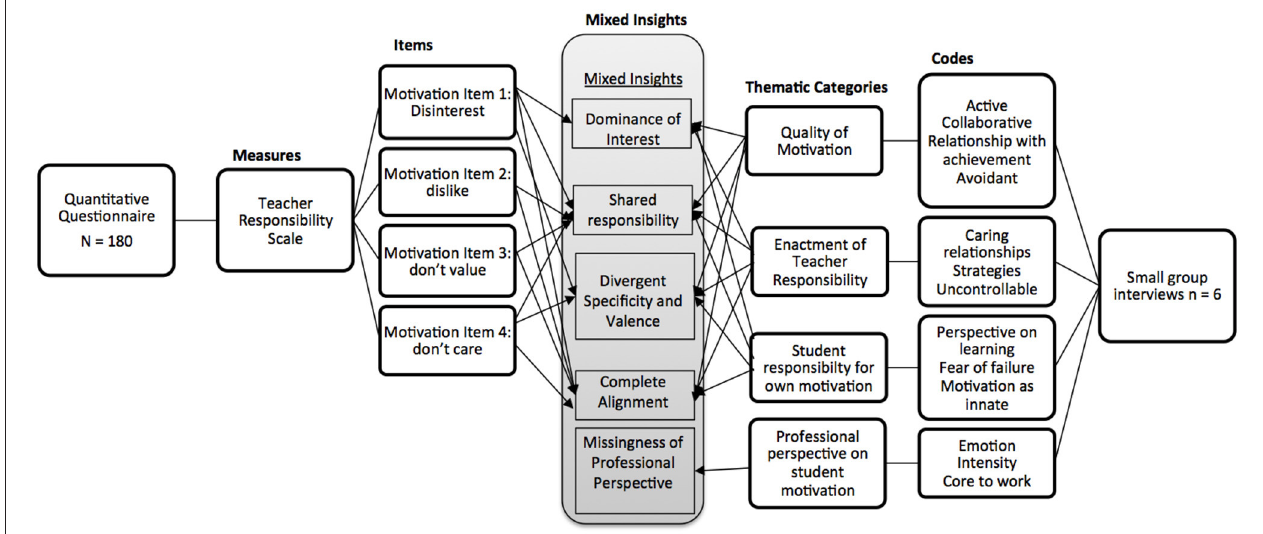
FIGURE 2 | Visual representing the qualitative dominant crossover analysis